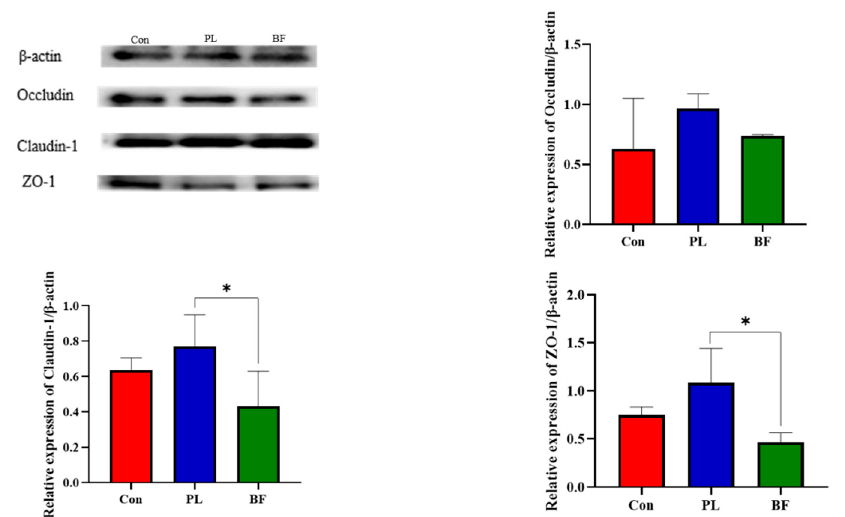
Figure 6. Effect of L. plantarum Y42 in the planktonic and biofilm states administration on the TJ proteins expression in mice; *: p < 0.05. All data are presented as mean ± SD. Note: Con means control group; PL means planktonic group; BF means biofilm group.